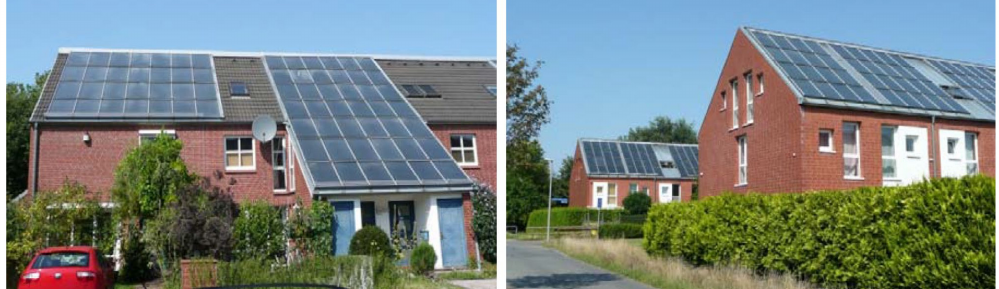
Figure 2. Terraced houses in Hamburg-Bramfeld, Germany,